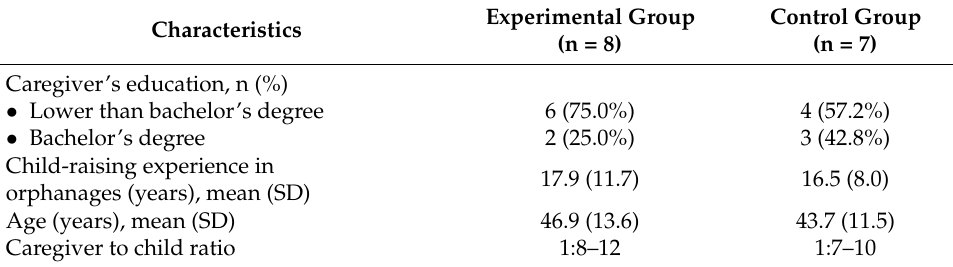
Table 2. Characteristics of main caregivers in